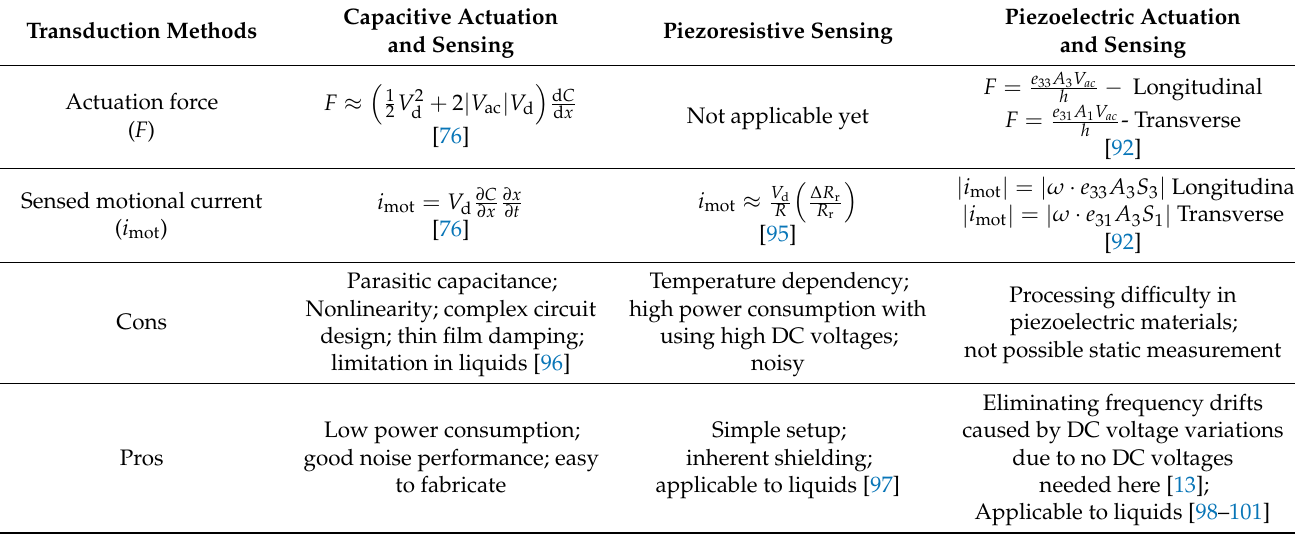
Description of several classic transduction mechanisms applied to coupled BAW MEMS